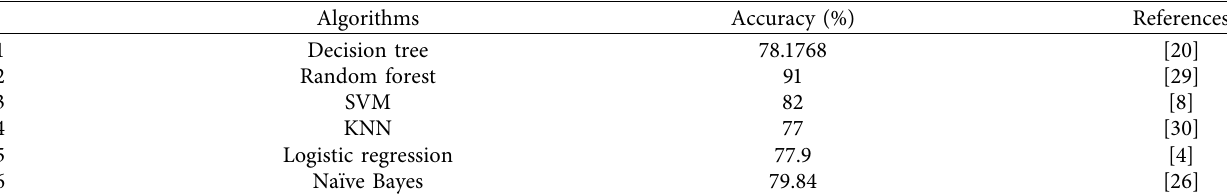
Table 6: The machine learning accuracy of existing works.